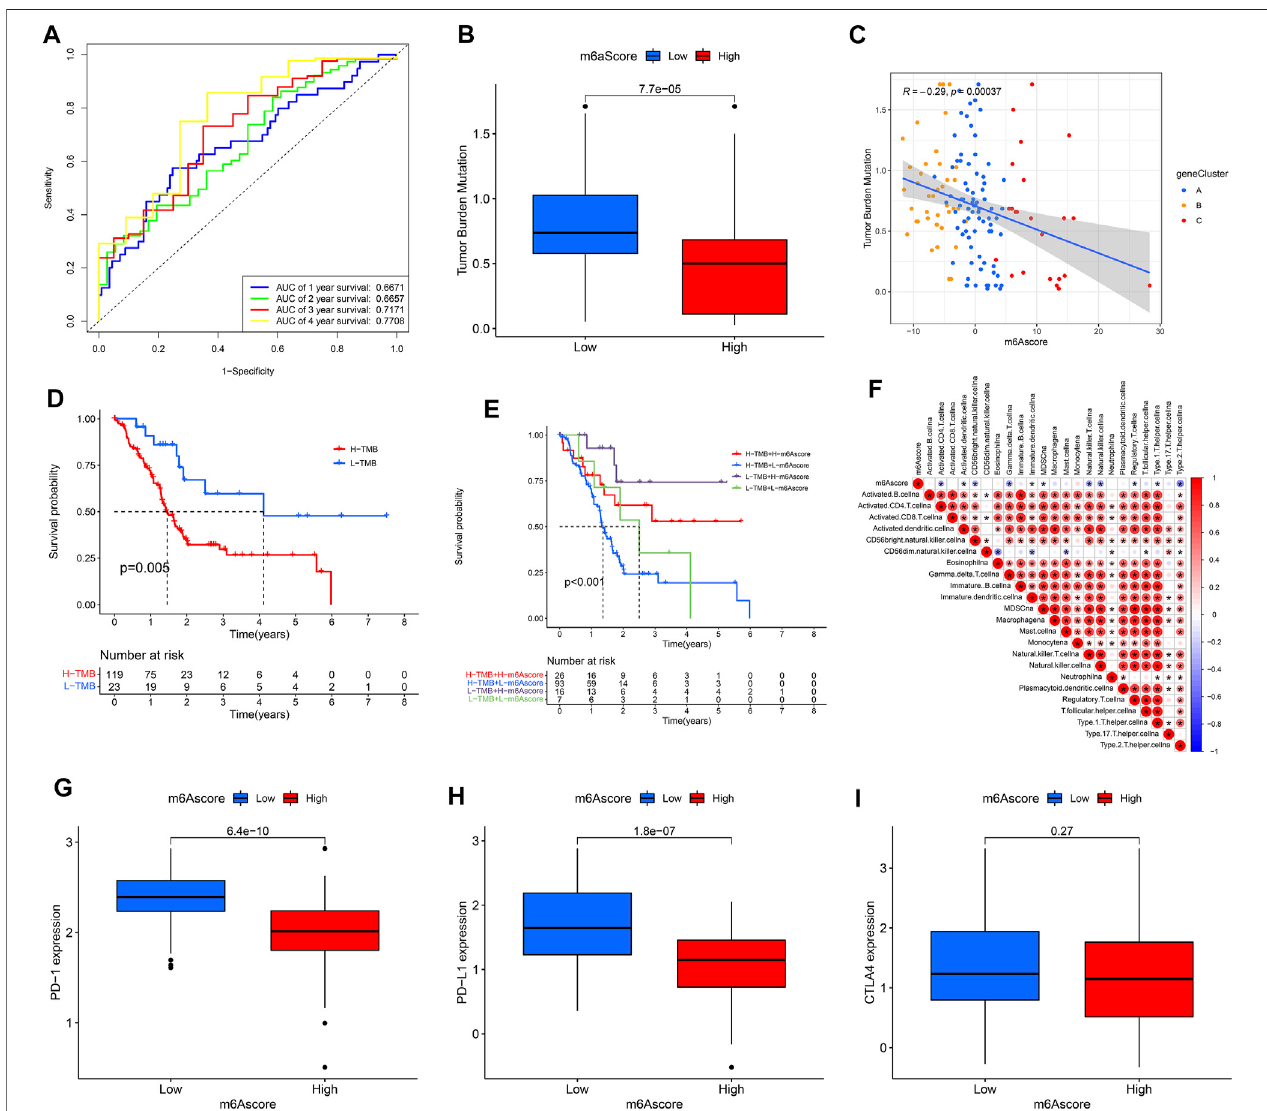
FIGURE8| Clinicalvalueofm6Ascoremodel. (A) Receiveroperatingcharacteristic(ROC)curvesofm6Ascoreforpredictingthe1/2/3/4-yearsurvival; (B,C) tumor mutation burden (TMB) correlation analysis; (D) KM analysis of patients with distinct TMB; (E) KM analysis of patients with distinct TMB and m6Ascore; (F) Immuno- correlationanalysis; (G) PD1 expression ofpatients indistinctm6Ascoregroups; (H) PD-L1 expression ofpatientsindistinct m6Ascoregroups; (I) CTLA4expression of patients in distinct m6Ascore